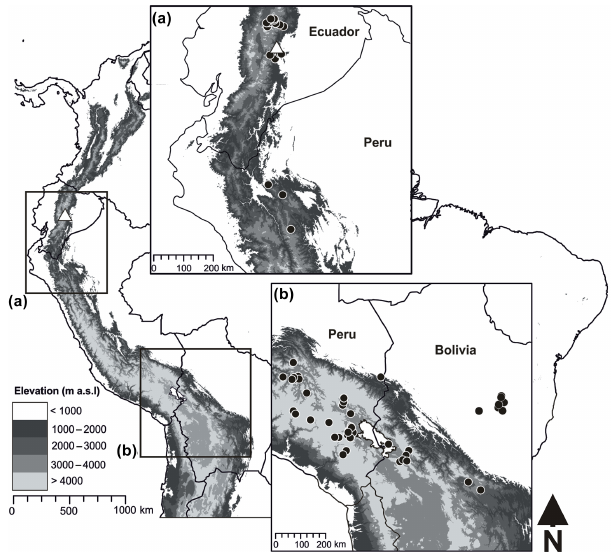
Figure 1. Location of the calibration data set lakes (black circles) and Laguna Pindo (white